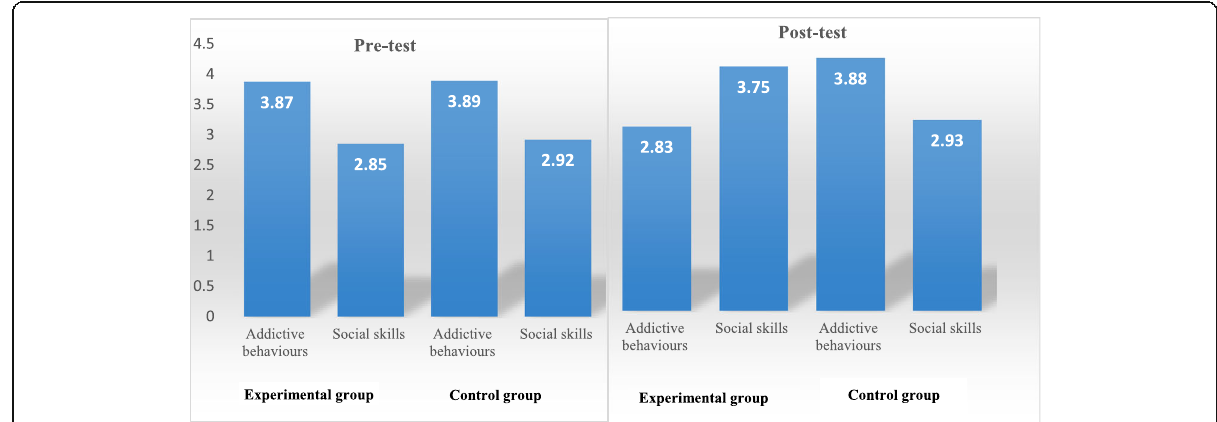
Fig. 1 Addictive behaviors and social skills on pre- and post-tests for study groups